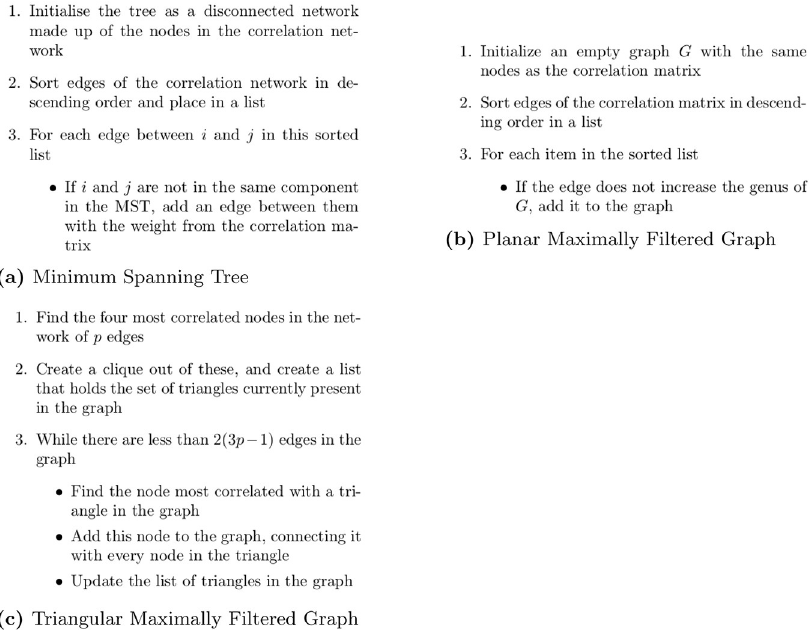
Fig 1. Pseudo code for the described topological filtration methods. ( a ) Minimum Spanning Tree, ( b ) Planar Maximally Filtered Graph, ( c ) Triangular Maximally Filtered Graph.